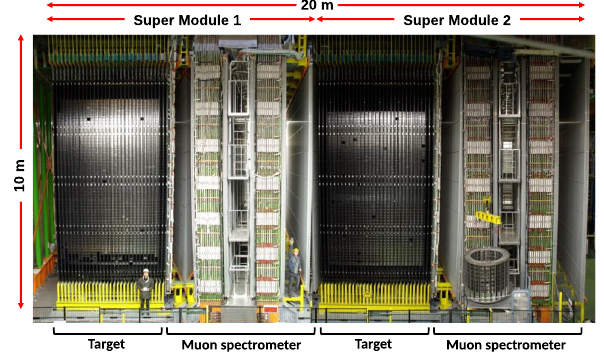
Fig. 1 Side view of the OPERA detector. The neutrino beam was com- ing from the left. The upper horizontal lines indicate the two identical supermodules (SM1 and